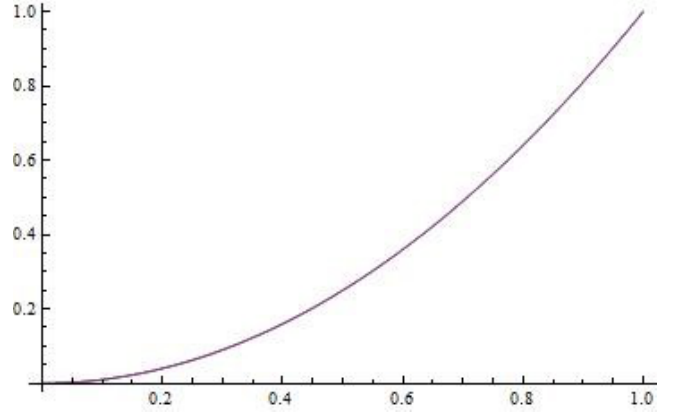
Fig. 2 Graph of the solution using AIM for the interval [ 0 , 1 ) .